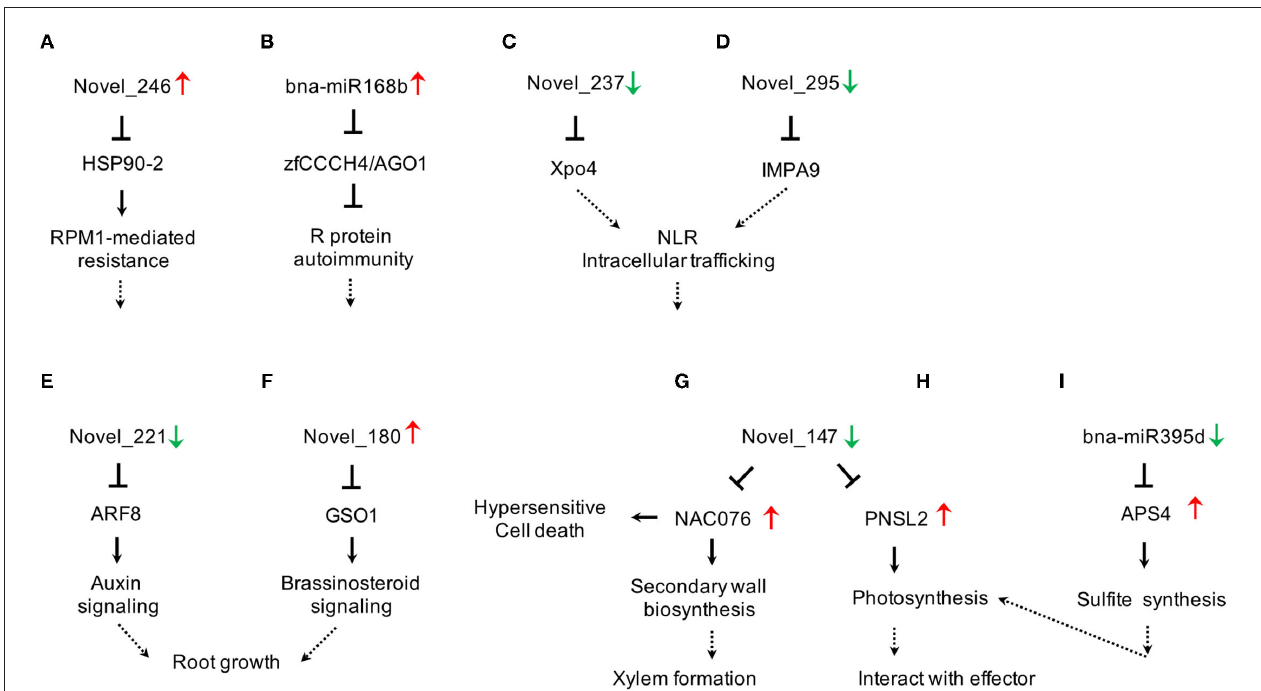
FIGURE 5 | Diverse cellular pathways regulated by miRNA-target modules in clubroot-resistant B. napus in response to P. brassicae . (A,B) Novel_246-HSP90-2 and bna-miRA168b-zfCCCH4/AGO1 for miRNA biogenesis; (C,D) Novel_237-Xpo4 and novel_295-IMPA9 for NLR signalling; (E,F) Novel_221-ARF8 and Novel_180-GSO1 for root growth; (G,H) Novel_147-NAC076/PNSL2 for secondary wall biosynthesis and photosynthesis; (I) bna-miR395d-APS4 for sulphite synthesis. Up- or Down- regulation of miRNAs or target transcripts were indicated by red or green arrows,